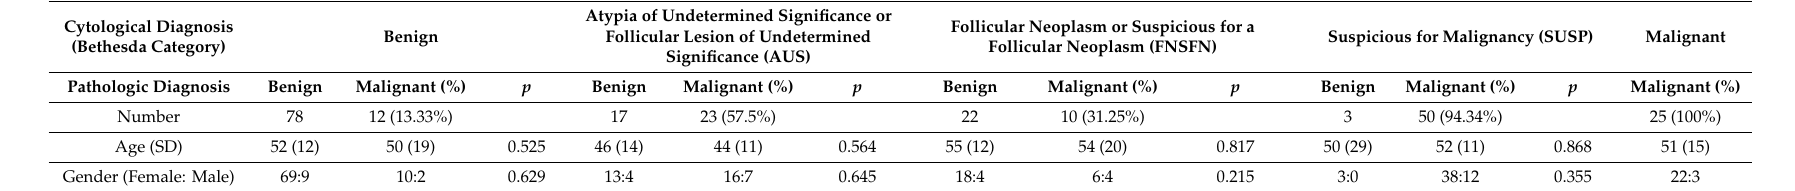
Table 1. Basic characteristics of the study